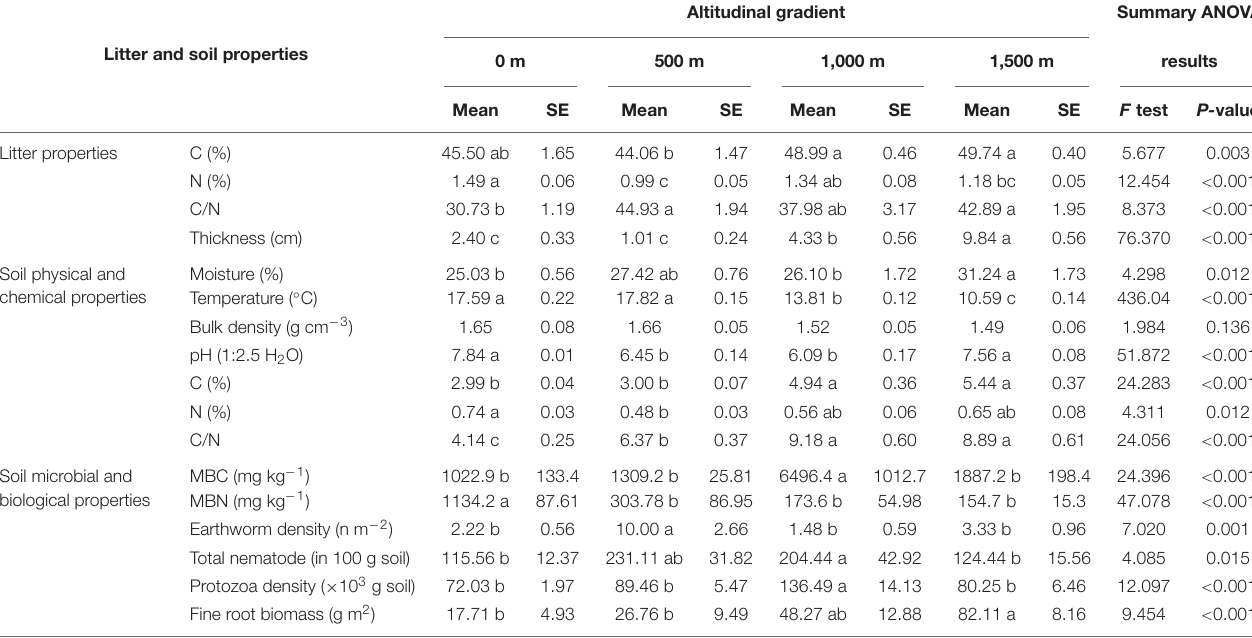
Altitudinal gradient Summary